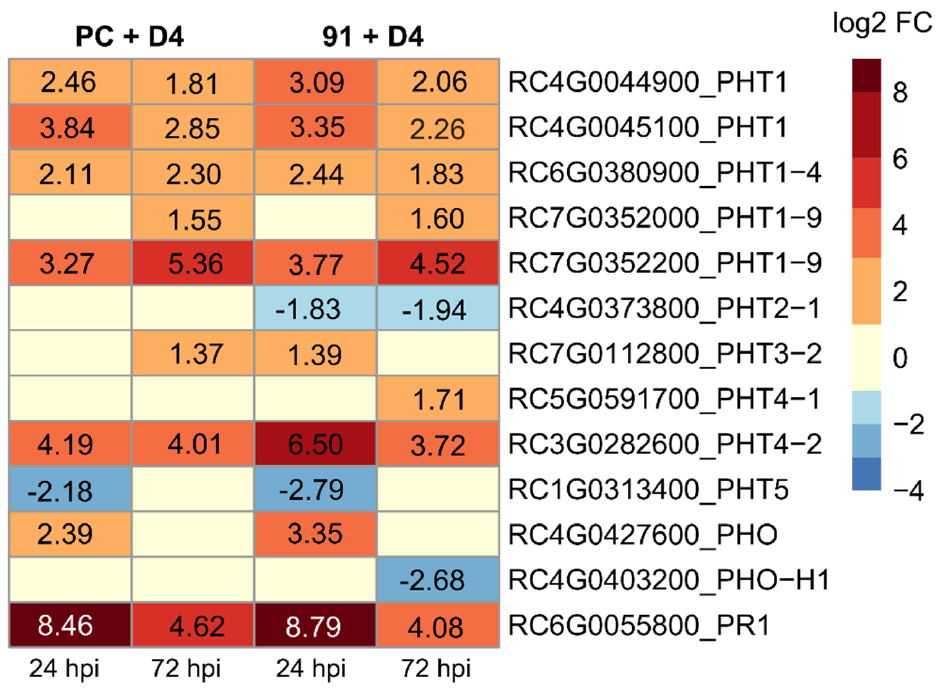
Figure 1. Heatmap showing transcriptional changes relative to mock inoculation of several phosphate transporters in rose leaves after inoculation with the fungal pathogen D. rosae (“D4”) at 24 and 72 hpi. PC: susceptible ‘Pariser Charme’, 91: resistant to “D4”. Additionally the regulation of RcPR1 is shown. Only RcPHTs with significant changes are included, n = 3.